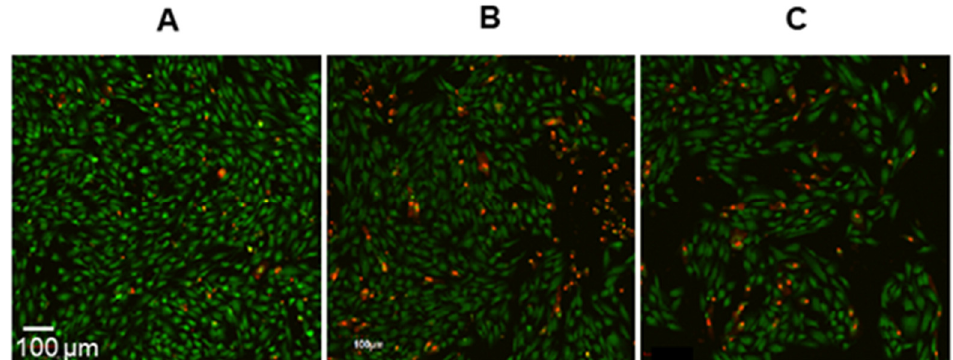
Figure 3. Confocal microscope images of RPE cells stained with fluorescent dye Live and Dead. The green channel AF 488 (Ex 490 nm/Em 525 nm) and red channel AF 594 (Ex 590 nm/Em 617 nm) were used. Magnification: 100 × . Living cells are green and dead cells are red. ( A ) Control RPE cell sample without lipofuscin granules (LGs). ( B ) LG-fed RPE sample. ( C ) LG*-fed RPE sample. The images were obtained after the samples were irradiated with visible light for 18 h and then maintained in the dark for 4 days.